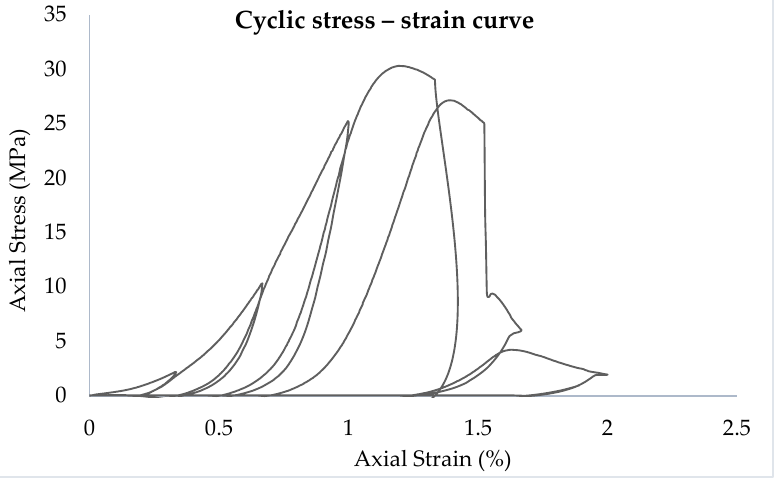
Figure 10. Axial stress versus axial strain curves of C-C0S2 concrete cylinder confined with epoxy- based SFRP under cyclic axial load.